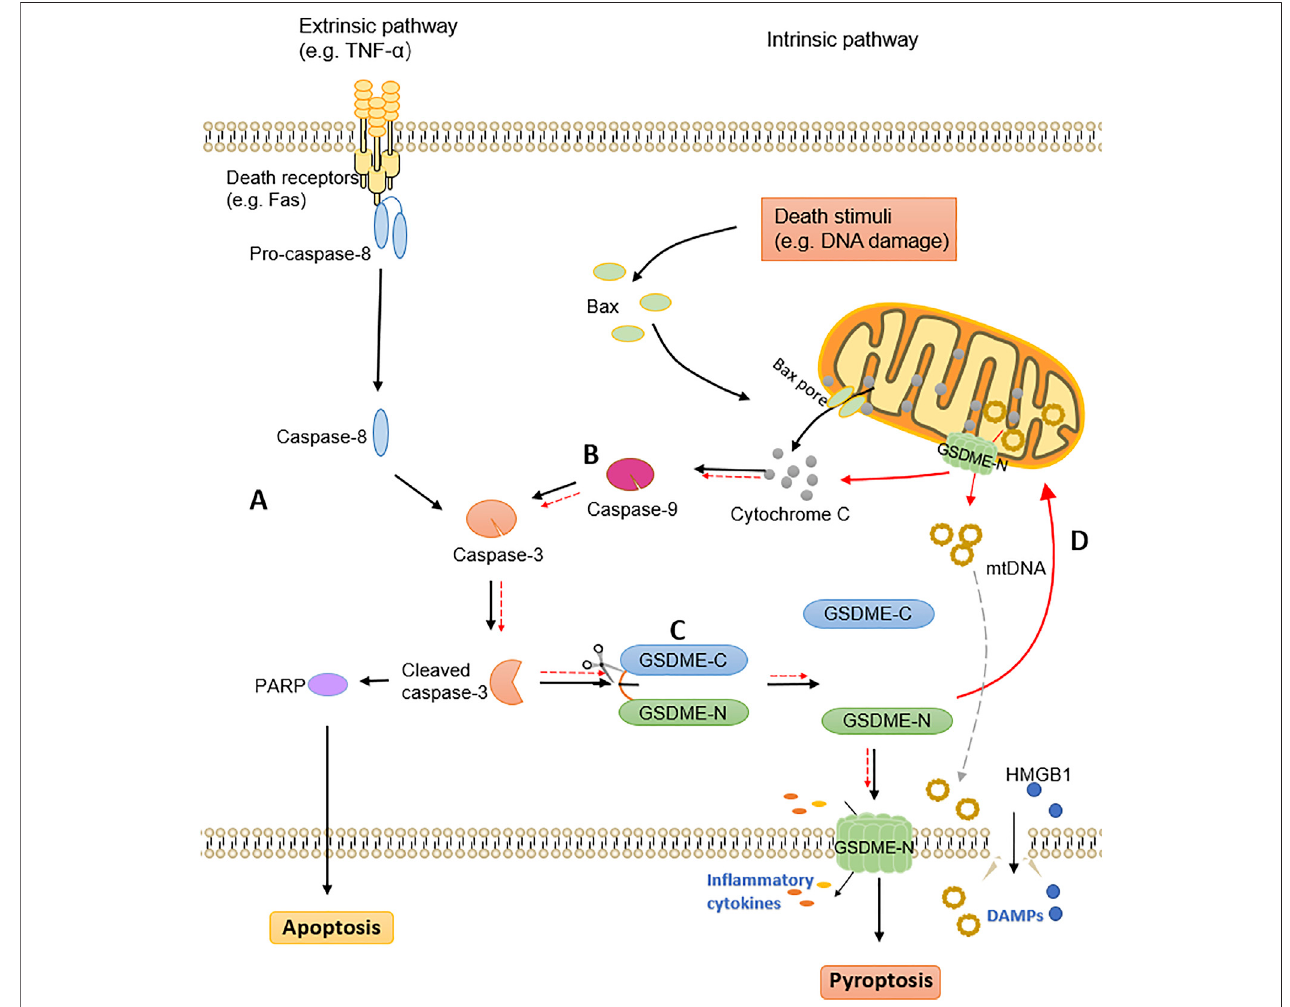
FIGURE1| ThecrosstalkofapoptosisandGSDME-dependentpyroptosis. (A) Theextrinsicpathwayofapoptosis. (B) Theintrinsicpathwayofapoptosis. (C) The pyroptosis mediated by GSDME. Cleaved caspase-3 activates GSDME to generate GSDME-N fragments, which translocate to the plasma membrane and perforate to release in fl ammatory cytokines. DAMPs are released after cell rupture, ultimately leading to pyroptotic cell death. (D) GSDME-N targets mitochondrial membranes to form pores, releasing cytochrome C and mitochondrial DNA. Further activation of caspase-3 leads to self-ampli fi cation of pyroptosis.